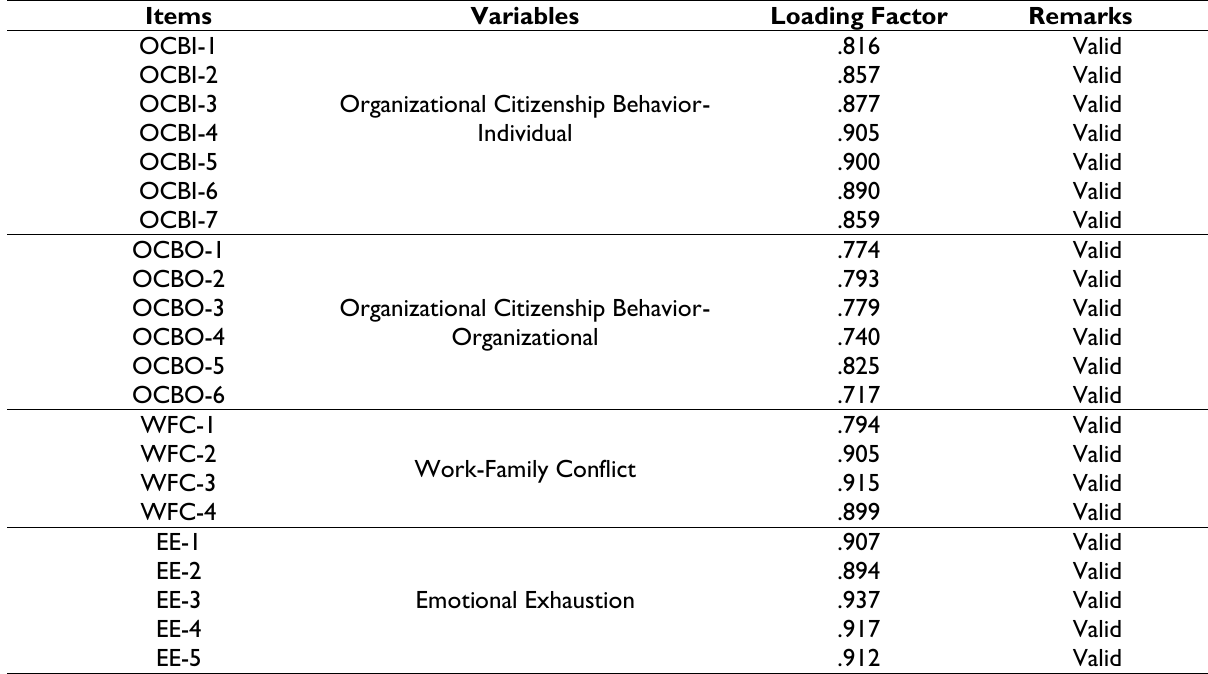
Table 3. Convergent Validity Results